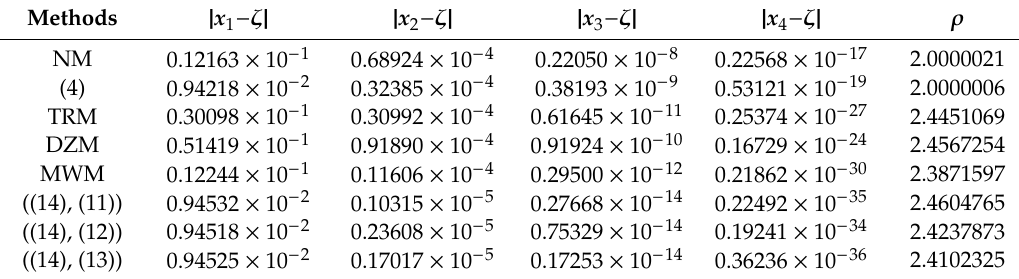
Table 9. Numerical results for function f 9 ( x ) .